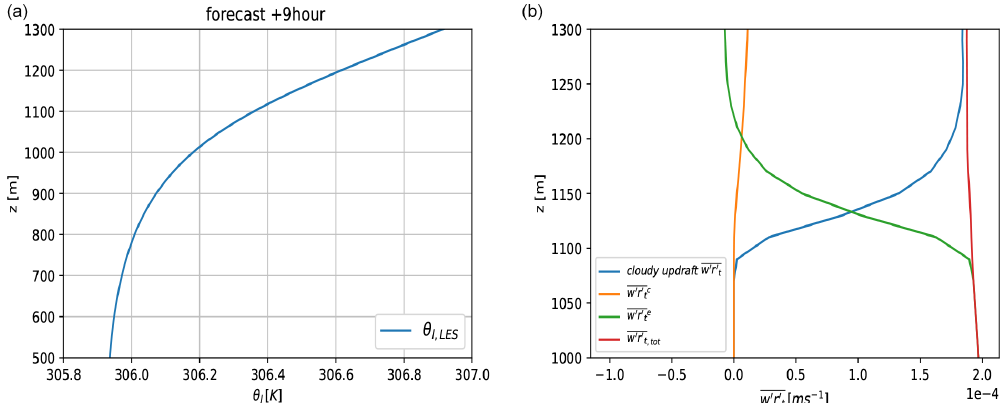
Figure 8. LES results around the cloud base inversion height for the ARM case at the ninth simulation hour. Panel (a) shows the θ l profile, whereas (b) presents a decomposition of the kinematic turbulent moisture fluxes (ms − 1 ). Plotted are LES cloudy updraft flux (blue), small- scale subplume transport (orange), small-scale environmental transport (green), and total transport (red). Note the different y -axis scale.